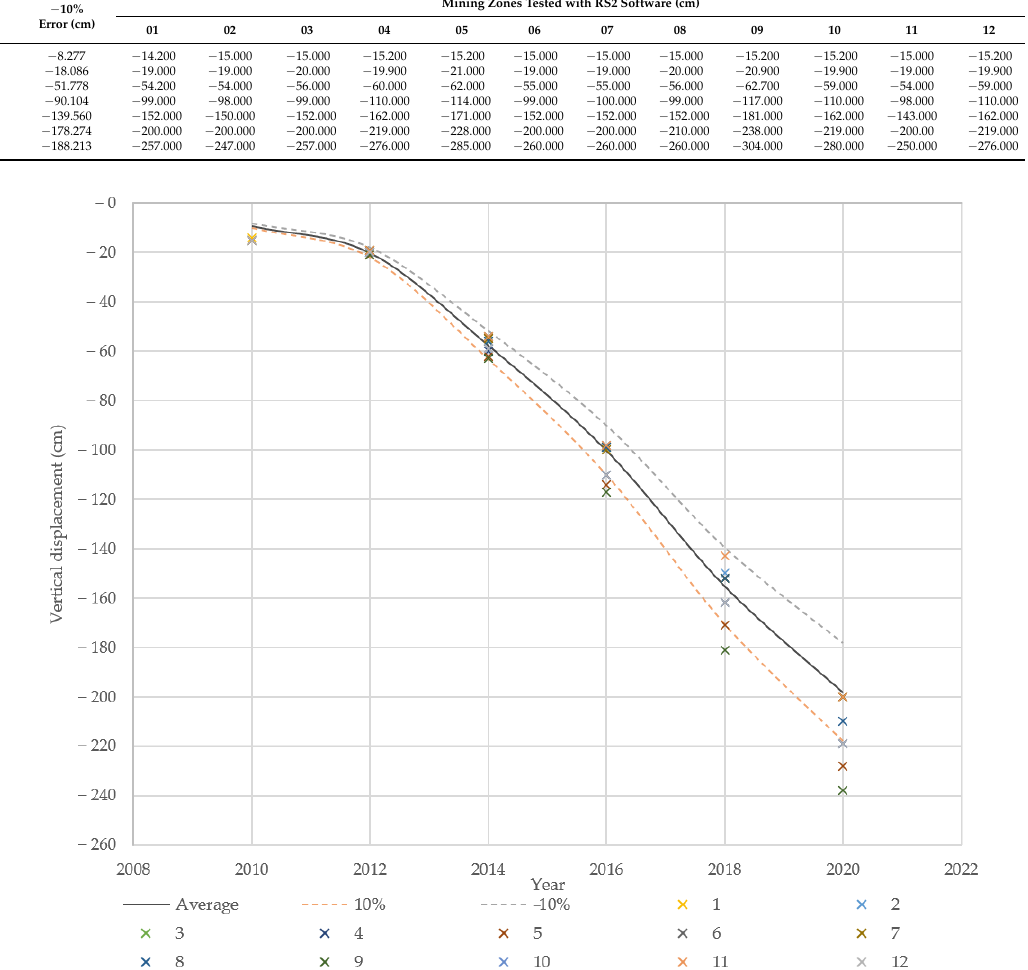
Figure 11. Average subsidence profile with the results of the sections analyzed. Another factor to consider is the subsidence measured on the surface, using GPS. As mentioned in the methodology, it has a potential error between 2 and 3 cm. This means